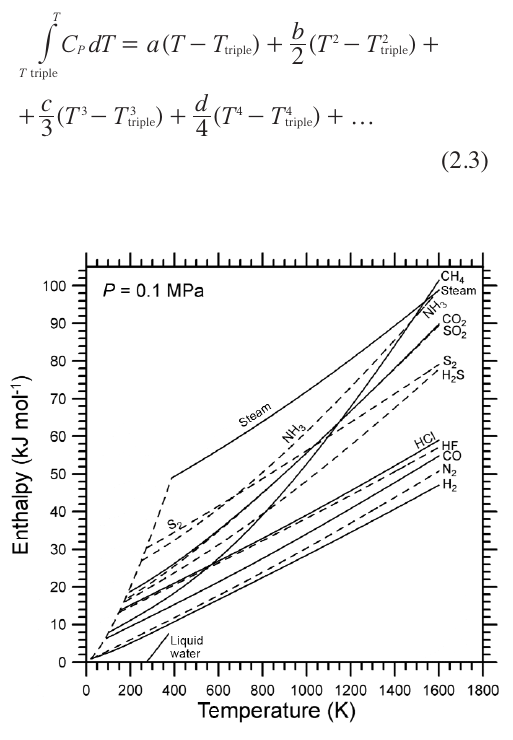
Fig. 1. Enthalpies of H 2 O ( l ) , H 2 O ( g ) , H 2( g ) , CO 2( g ) , CO ( g ) , CH 4( g ) , N 2( g ) , NH 3( g ) , S 2( g ) , SO 2( g ) , H 2 S ( g ) , HCl ( g ) , and HF ( g ) at 0.1 MPa pressure and variable